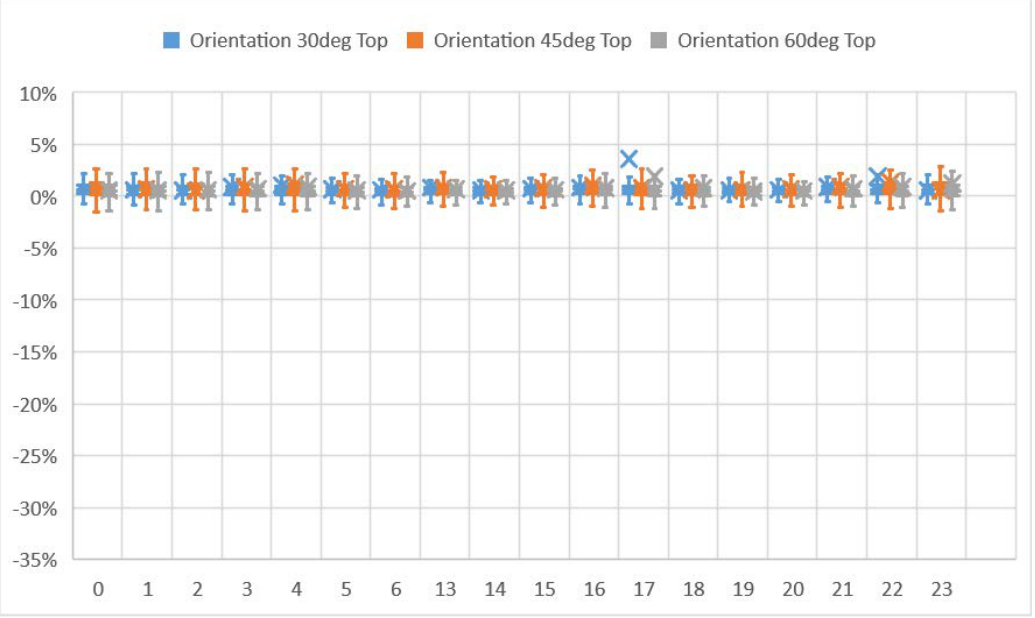
( d ) Box charts for hourly percentage difference in a year for tests for the Top Floor, (1) Infiltration decreased to 0.3 ach; (2) Infiltration decreased to 0.6 ach; (3) Window-to-Wall Ratio reduced to 14.9%. Figure A3.